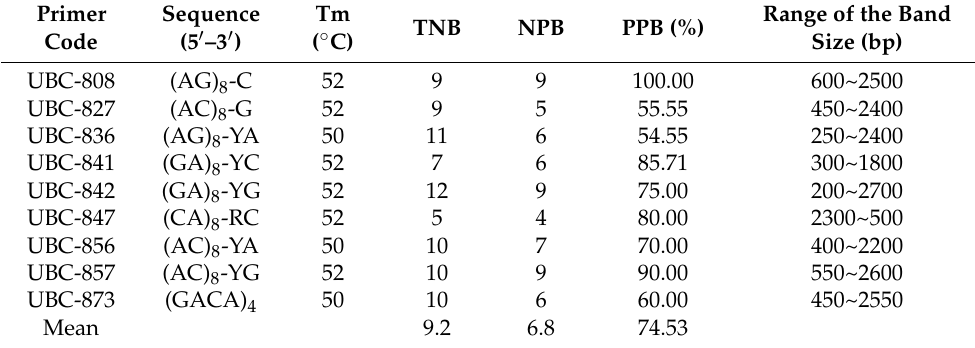
Table 2. Amplification of ISSR markers in 54 samples of castor seeds.